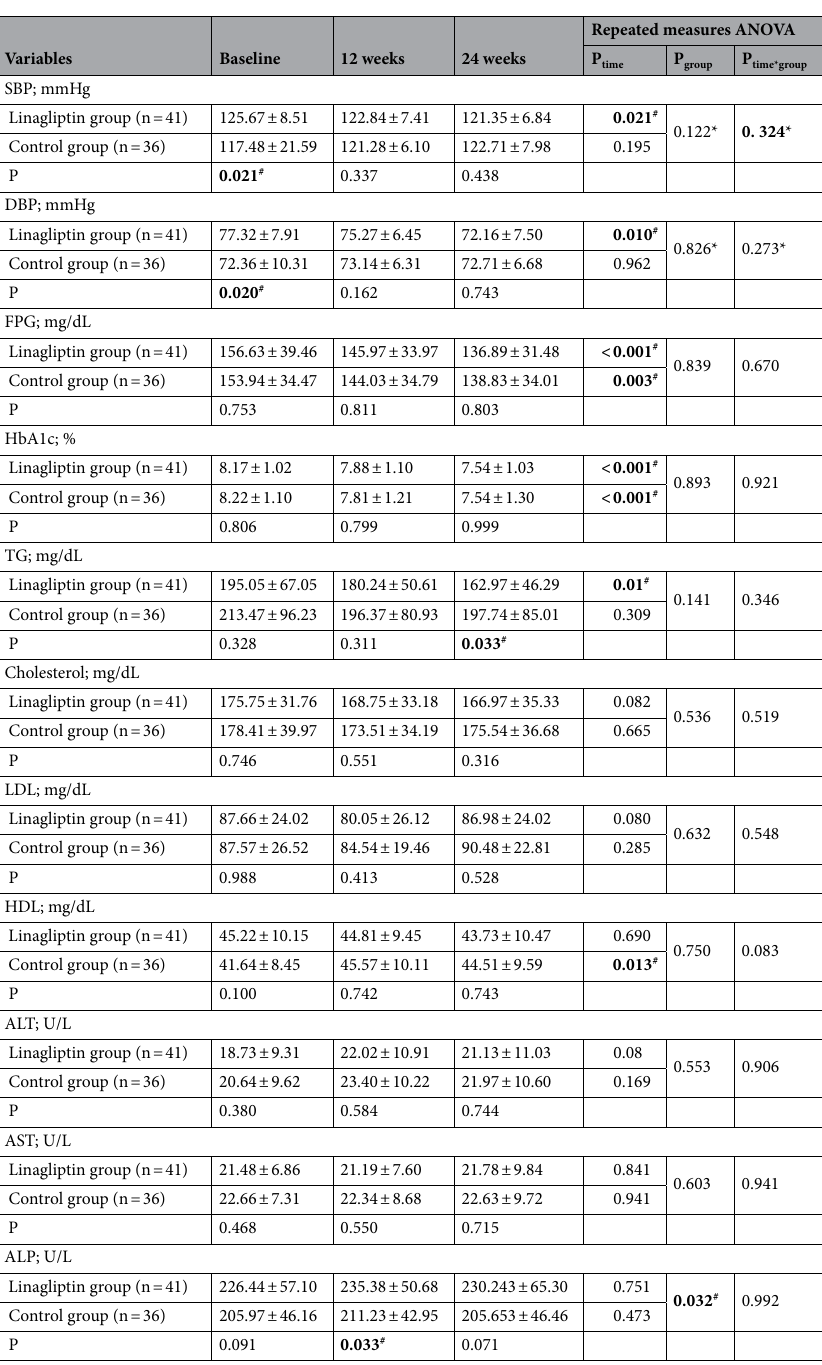
Table 3. Parameters of diabetic patient’s blood pressure, plasma glucose, lipid profile, and liver enzymes in linagliptin and placebo treated groups. SBP systolic blood pressure, DBP diastolic blood pressure, FPG fasting plasma glucose, HbA1C hemoglobin A1c, TG triglycerides, LDL low-density lipoprotein, HDL high-density lipoprotein, ALT alanine aminotransferase, AST aspartate aminotransferase, ALP alkaline phosphatase. P is obtained from an independent samples t -test conducted for comparing the mean of the variables between the two groups at each follow-up time point. P group indicates the overall difference between the two groups over the follow-up period. P time shows the changes in the mean of the variables in the intervention and control groups separately over the follow-up period. P time*group demonstrates the interaction between the time and intervention. P group , P time , and P time*group was obtained from repeated measures ANOVA. Significant values are given in bold. # Statistically significant results. *If the baseline values had a significant difference between the two groups, it was considered as a confounder and it was adjusted in the repeated measures